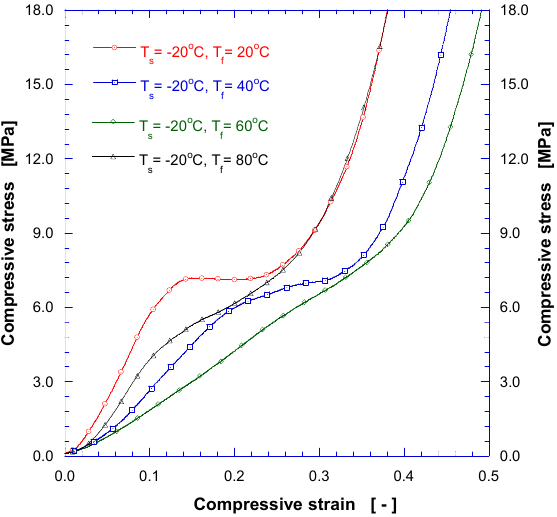
Figure 8. Compressive stress-strain curves for solid freeform PLA after foaming process.